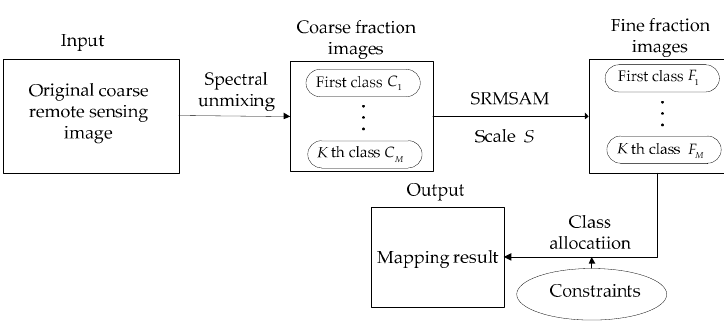
Figure 2. The flowchart of super-resolution mapping, based on the spatial attraction model (SRMSAM). Finally, the predicted value F m ( p n ) is used to allocate class labels into all subpixels by class allocation